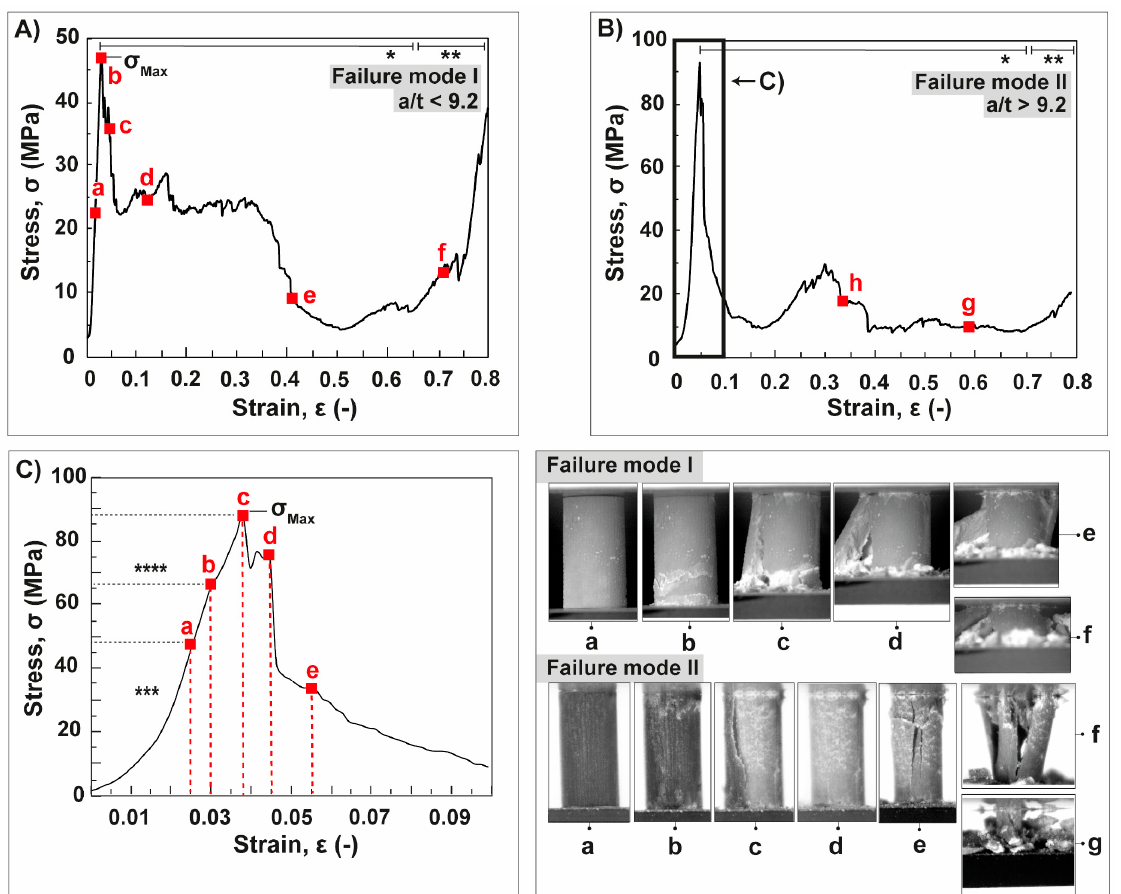
Figure 12. Spine segments of Phyllacanthus imperialis under uniaxial compression. Typical stress ( σ )-strain ( ε ) curves of failure mode I and II are demonstrated in ( A , B ), respectively. A detailed view of the initial stress–strain curve of a spine segment undergoing failure mode II is displayed in ( C ). The red letters belong to the microphotographs presenting the fracture behavior at a specific stage of uniaxial compression. *: ‘Quasi-ductile’ regime. **: Densification. ***: Linear elastic regime with a brief alignment period. ****: Dismantling of the cortex.